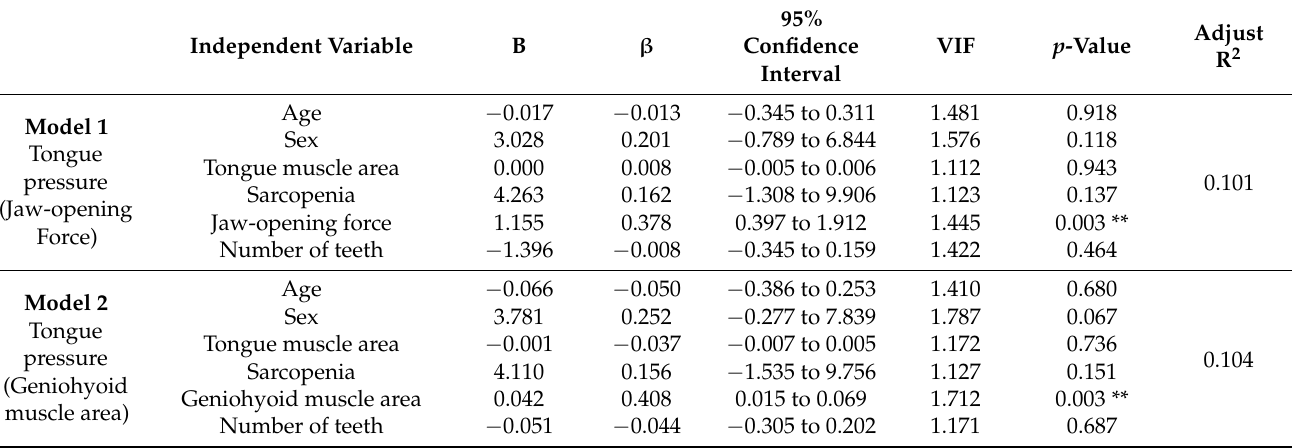
Table 5. Multivariate linear regression analysis of factors for tongue